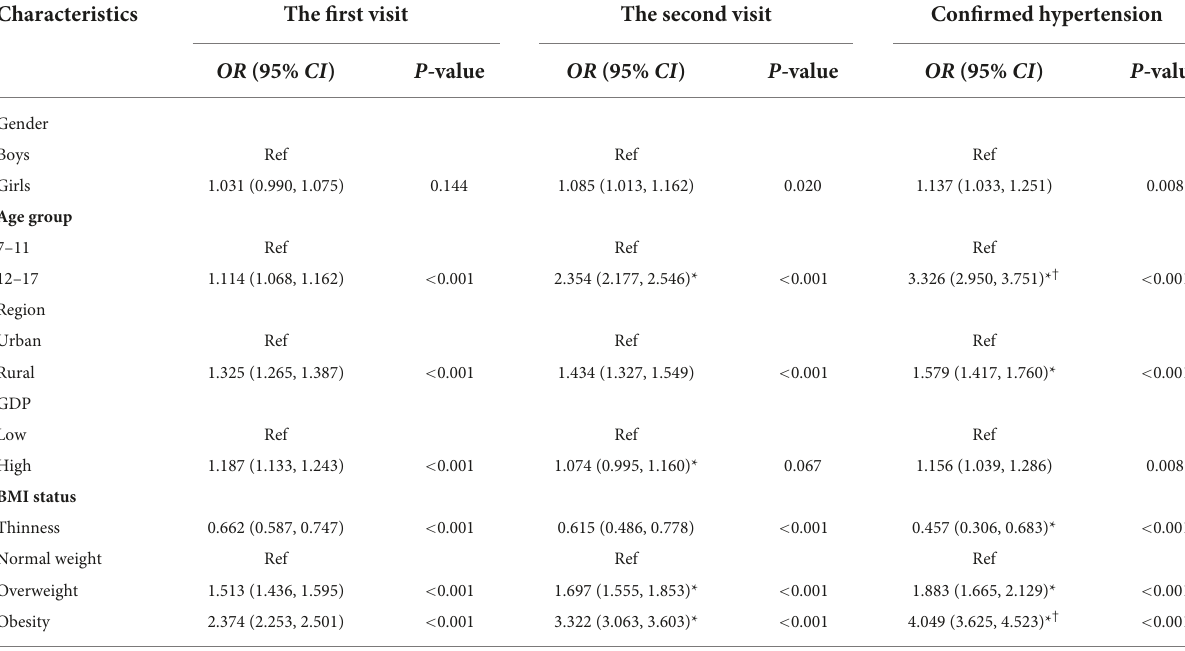
TABLE 3 Multivariate logistic regression analyses of the risk factors for hypertension at three separate visits. Characteristics The first